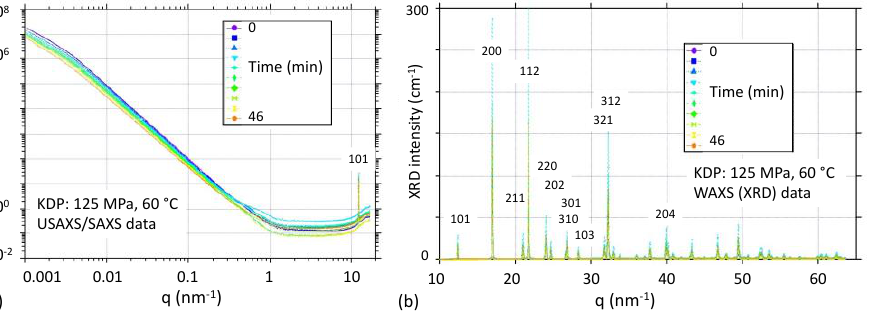
Figure 3. ( a ) In situ slit-smeared USAXS/SAXS line-trace data versus q for KDP CSP using p = 125 MPa at 60 °C. Point-to-point data uncertainties are indicated by scatter in the line traces. ( b ) Corresponding in situ WAXS (XRD) data with selected XRD peaks indexed.